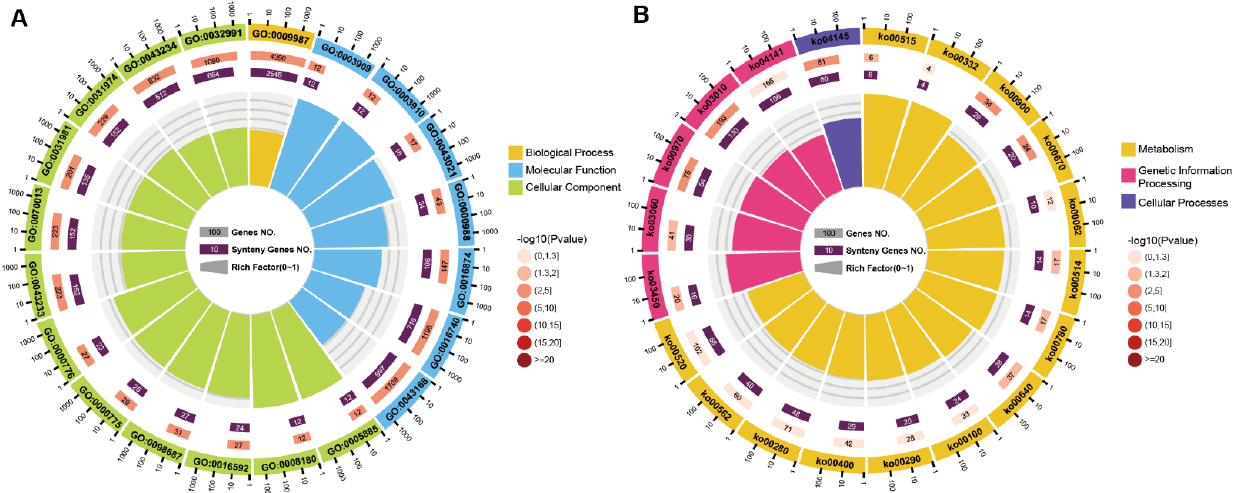
Figure 3 . KEGG and GO cluster of syntenic genes between the two monokaryotic genomes in a dikaryotic cultivar of Lentinula edodes . ( A ) GO term analysis of synteny genes. Yellow label belongs to biological process class; blue label belongs to molecular function class; green label belongs to cellular component class. ( B ) KEGG term analysis of synteny genes. Yellow label belongs to metabolism class; magenta label belongs to genetic information processing class; purple label